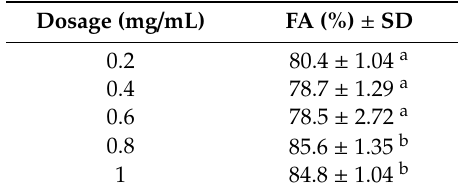
Table 2. Indicated the e ff ect of di ff erent bioflocculant concentrations on the flocculating activity of the purified bioflocculant.